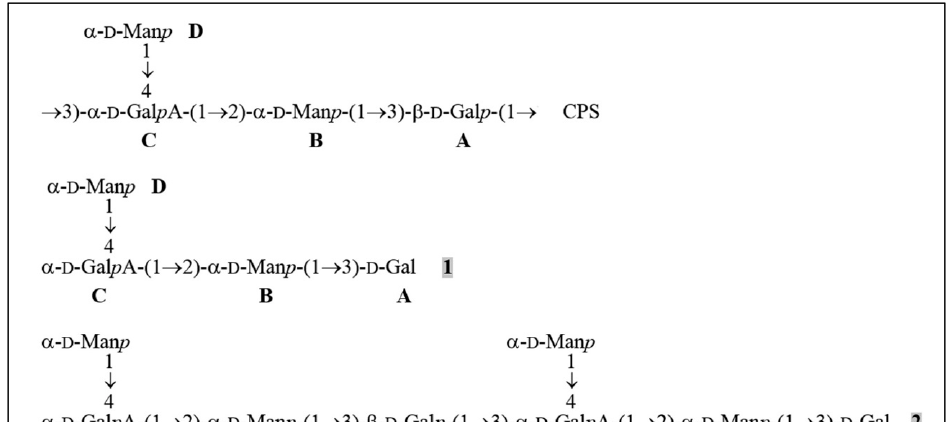
Figure 4. Structures of the K57 CPS of K. pneumoniae KPi8289 and oligosaccharides derived by cleavage of the CPS with depolymerase Dep_kpv79. CPS, tetrasaccharide repeat, containing two residues of D-mannose (units B and D ) and one residue each of D-galactose (unit A ) and D-galacturonic acid (unit C ). 1 and 2, oligosaccharides obtained by cleavage of the CPS_KPi8289 with Dep_kpv79 (the same oligosaccharides were obtained by CPS splitting with